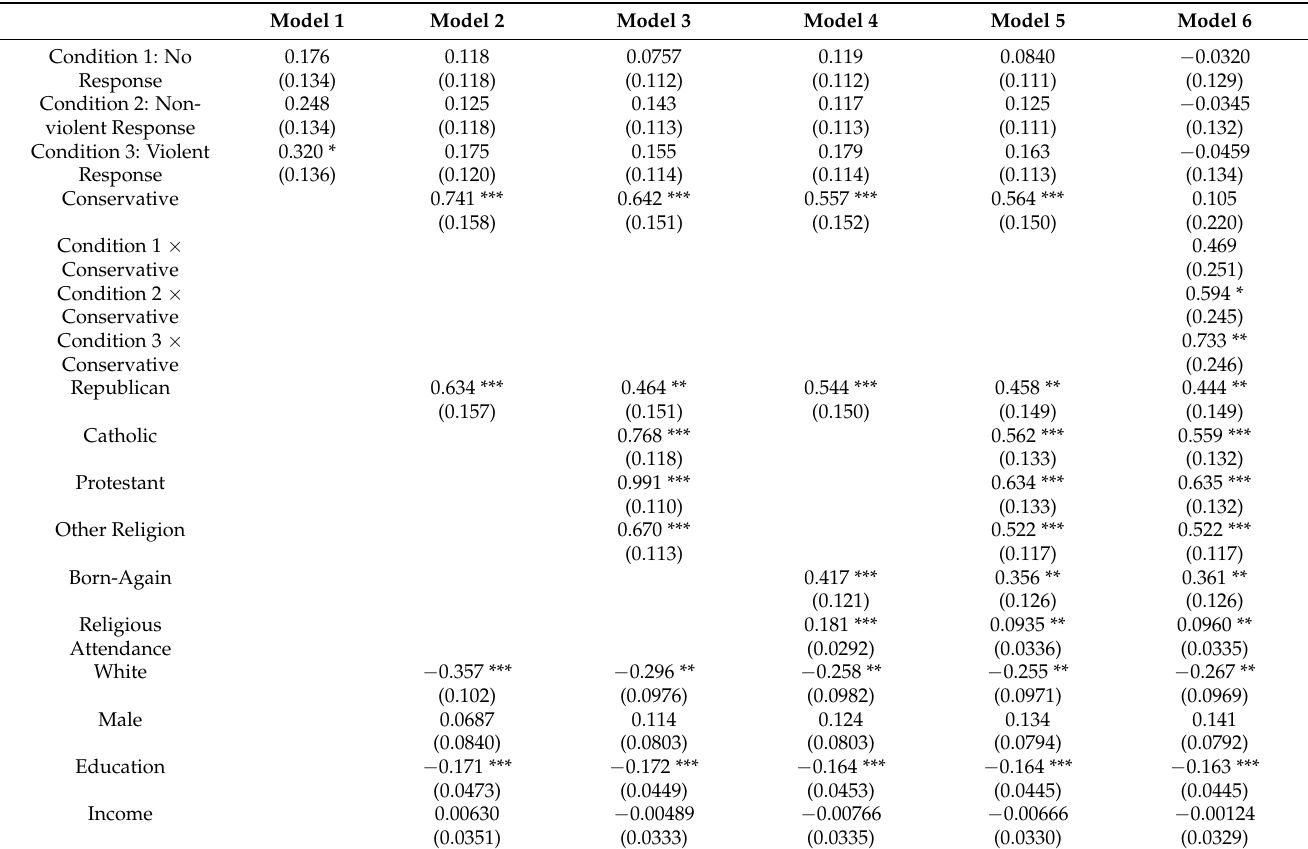
Table 5. Determinants of religious freedom threat